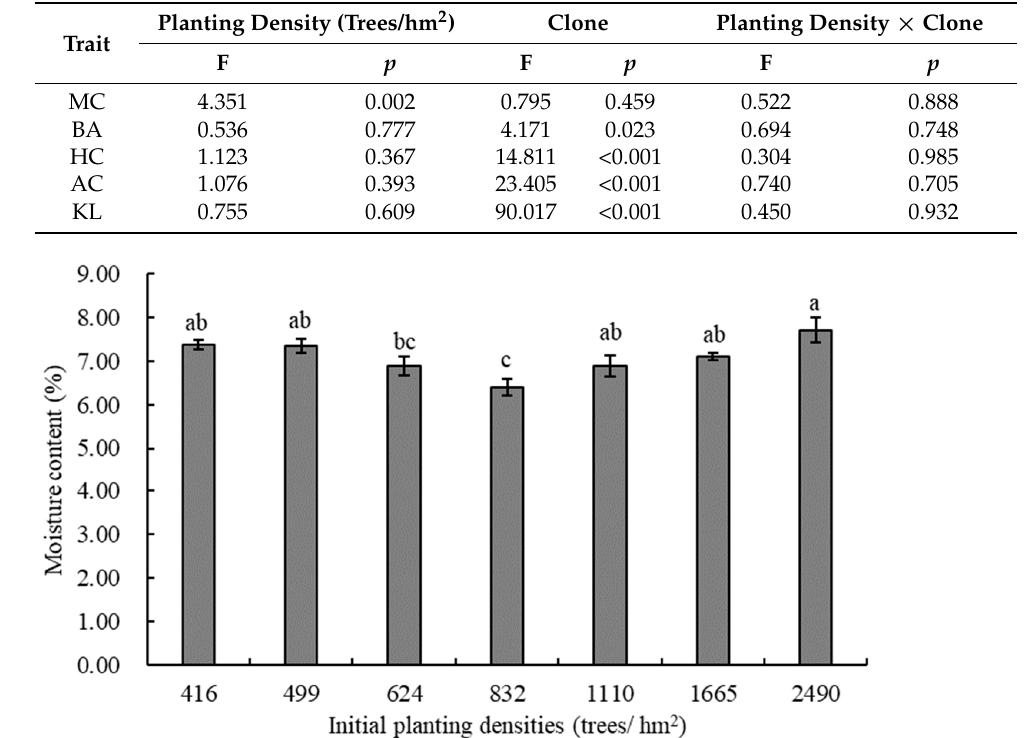
Table 3. Analyses of variance of the moisture content and chemical compositions of 11-year-old triploid Chinese white poplars for the combined seven planting densities.